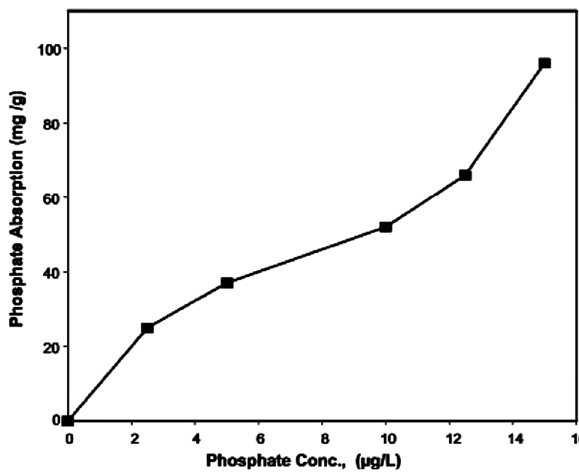
Fig. 2 Effect of the initial phosphate concentration on the uptake behavior of HDPE-g-PAAm treated with ethylenediamine/phthalic unhydride and loaded with Cu(II) (Senna et al.